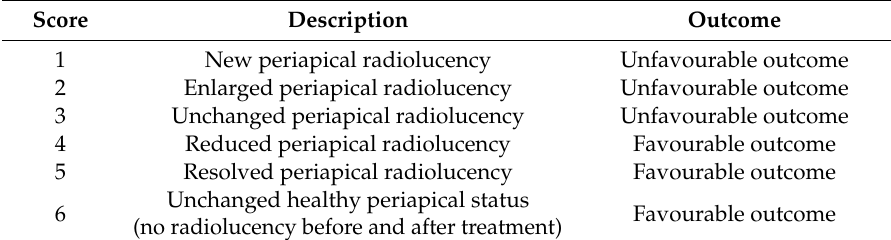
Table 1. The outcome categories for root canal treatment